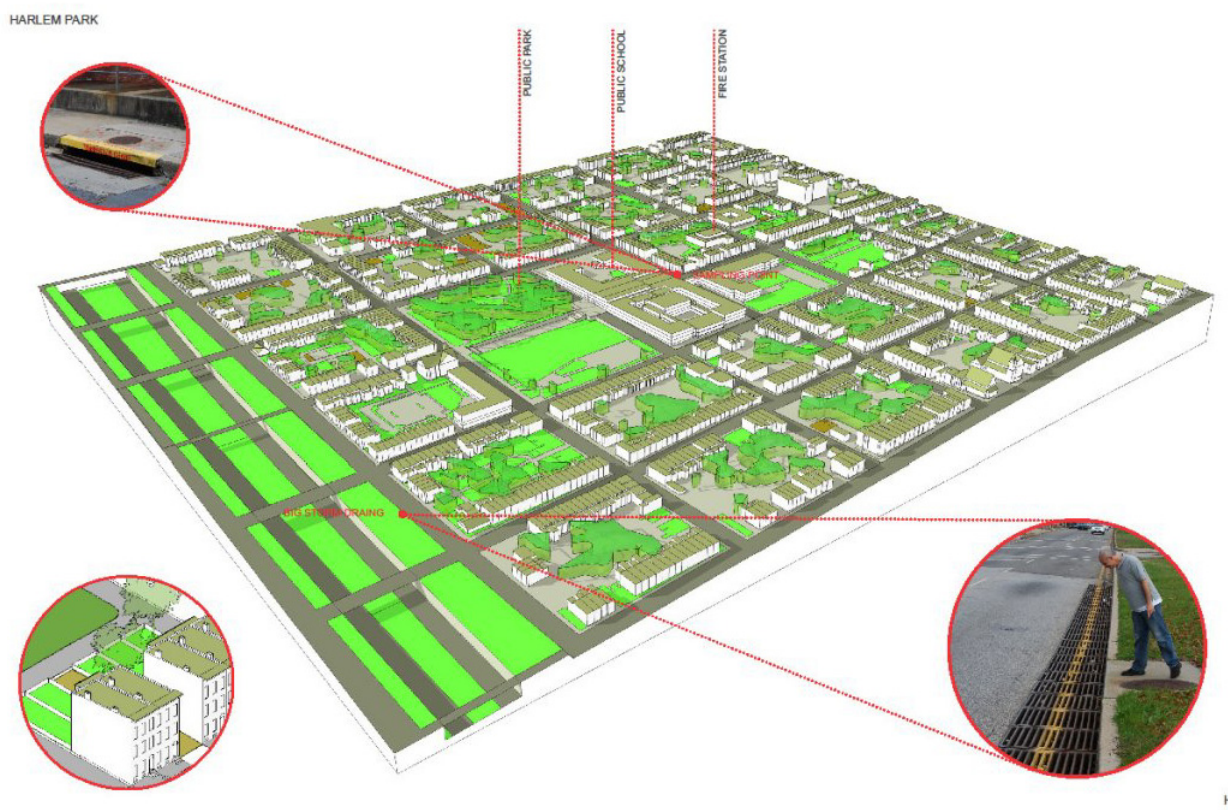
Figure 8. Harlem Park is a row house neighborhood comprising a piped sub-catchment called Watershed 263. Open space consists of historical parks, vacant lots, and sites cleared for parks, schools and highways during the period of Urban Renewal following World War II. (Courtesy of